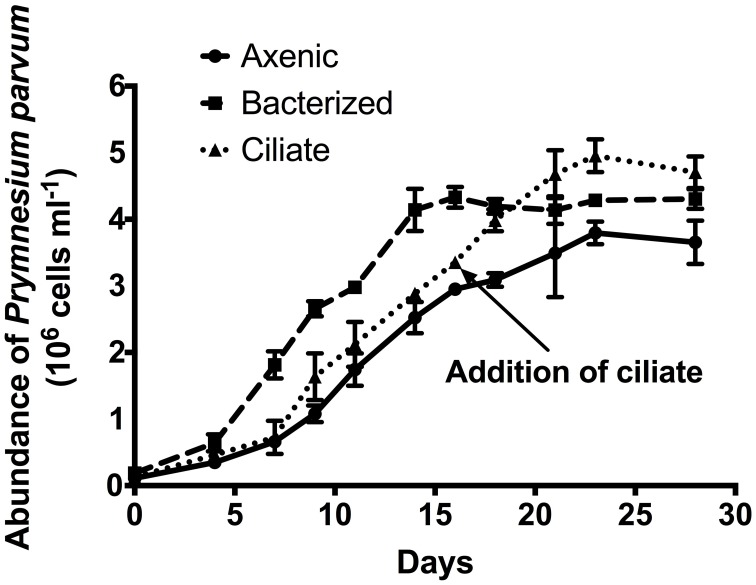
Growth of the prymnesiophyte, Prymnesium parvum, in axenic culture (circles, solid line), in non-axenic culture with attendant bacterial flora (squares, dashed line), and in axenic culture with the addition of ciliates at late exponential phase (triangles, dotted line). Arrow indicates Day 16 when ciliates were added to the axenic P. parvum culture. In the transcriptome experiment, cells were harvested from axenic and bacterized treatment just prior to the addition of ciliates, while cells were harvested from ciliate treatment ~6 h after the addition of ciliates. Symbols and error bars represent mean ± standard deviation of two replicates.